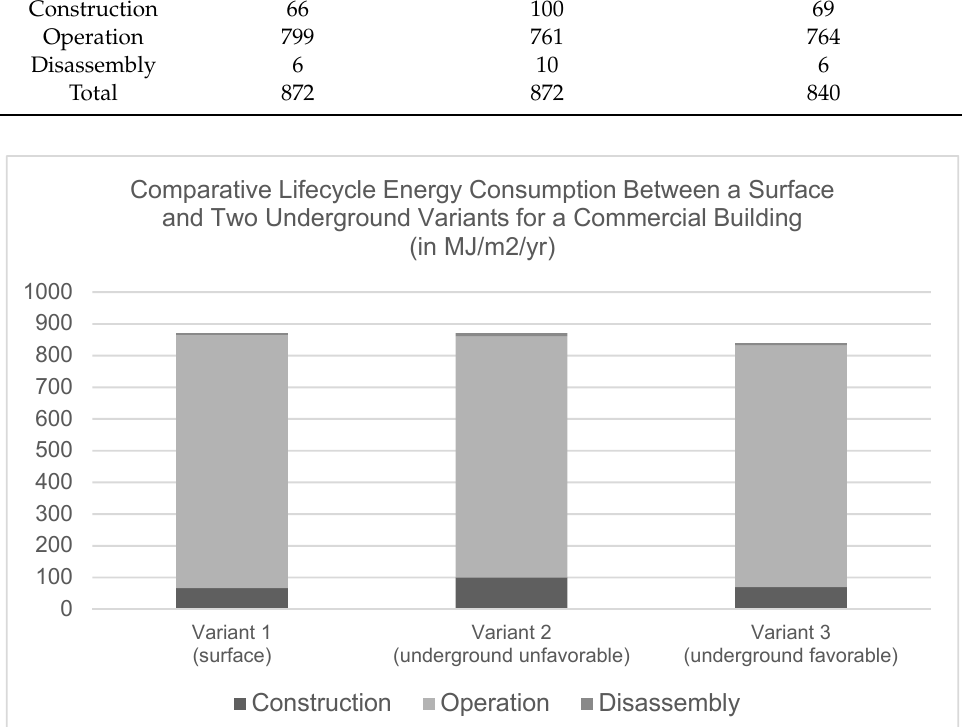
Figure 2. Estimated construction costs incurred by excavating in the less favorable (unconsolidated sediments) is compensated in comparison with the surface option by lower operating costs (adapted from Poux 2008, p. 63).